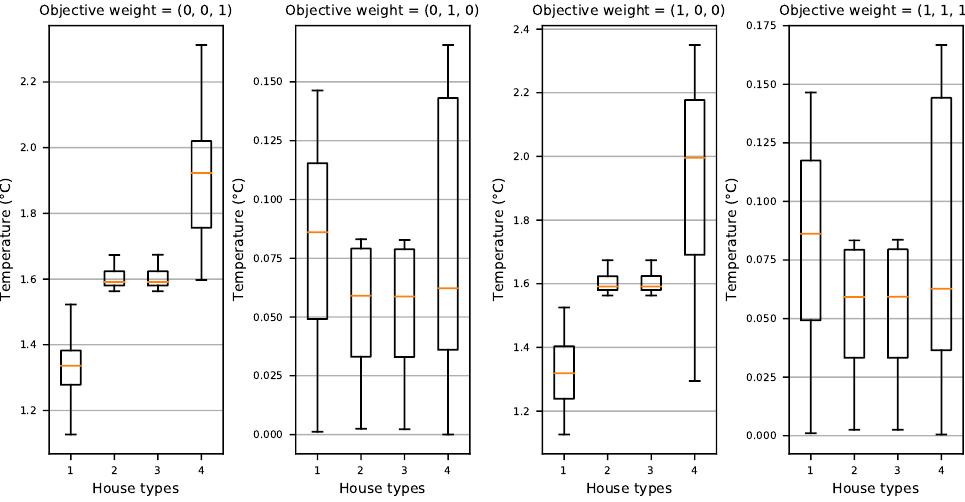
Figure 9. Schematic of Three-Phase